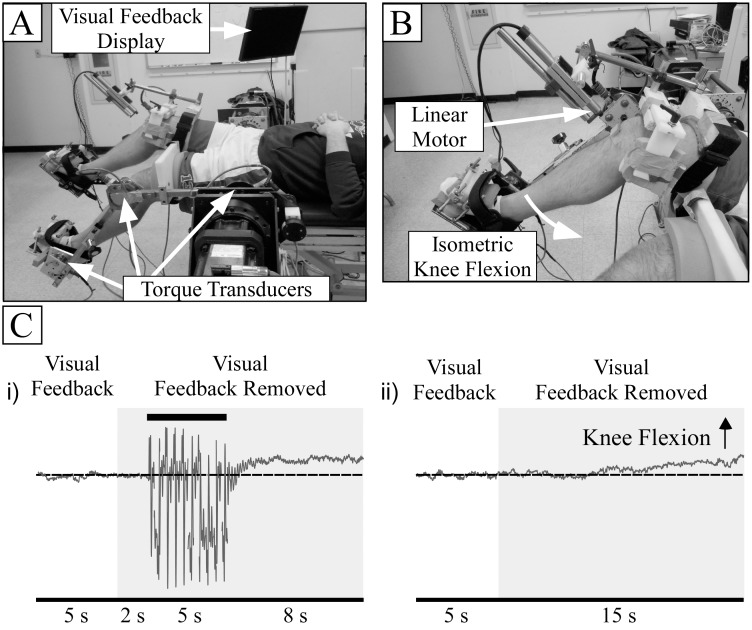
Experimental Setup.(A) Robotic apparatus used to measure knee torque during isometric contractions. Subjects were given visual feedback on a computer monitor during the initial 5 seconds of the trial to ensure they reached the correct contraction level. (B) A linear motor provided controlled tendon taps to the right patellar tendon. Ten tendon taps (2 Hz and 25 ms duration) were applied 2 seconds after visual feedback was removed. (C) Experimental time line for isometric knee flexion contraction with (i) and without (ii) tendon taps. After 5 seconds, visual feedback of knee flexion torque was removed for the remainder of the trial.